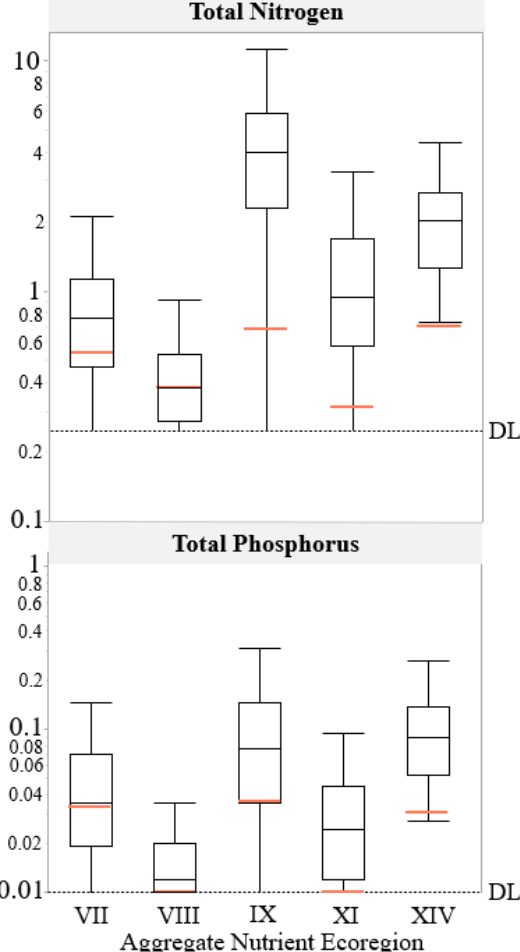
Figure 4. Tukey plots of total nitrogen and total phosphorus concentrations across the aggregate nutrient ecoregions of Pennsylvania, based on monitoring data for streams and rivers from 2000 to 2019. The red line is USEPA’s recommended regional criterion value for each ecoregion. The dashed line is the detection limit. Table 2. Total nitrogen and total phosphorus 25th percentile concentration values for USEPA’s aggregate nutrient ecoregions of Pennsylvania, from this study compared to other published concentrations.